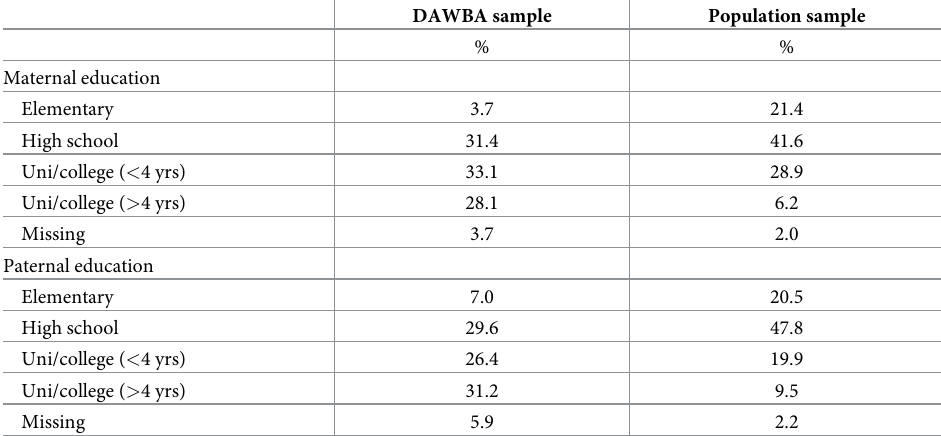
Table 1. Distribution of variables used for weighting the survey